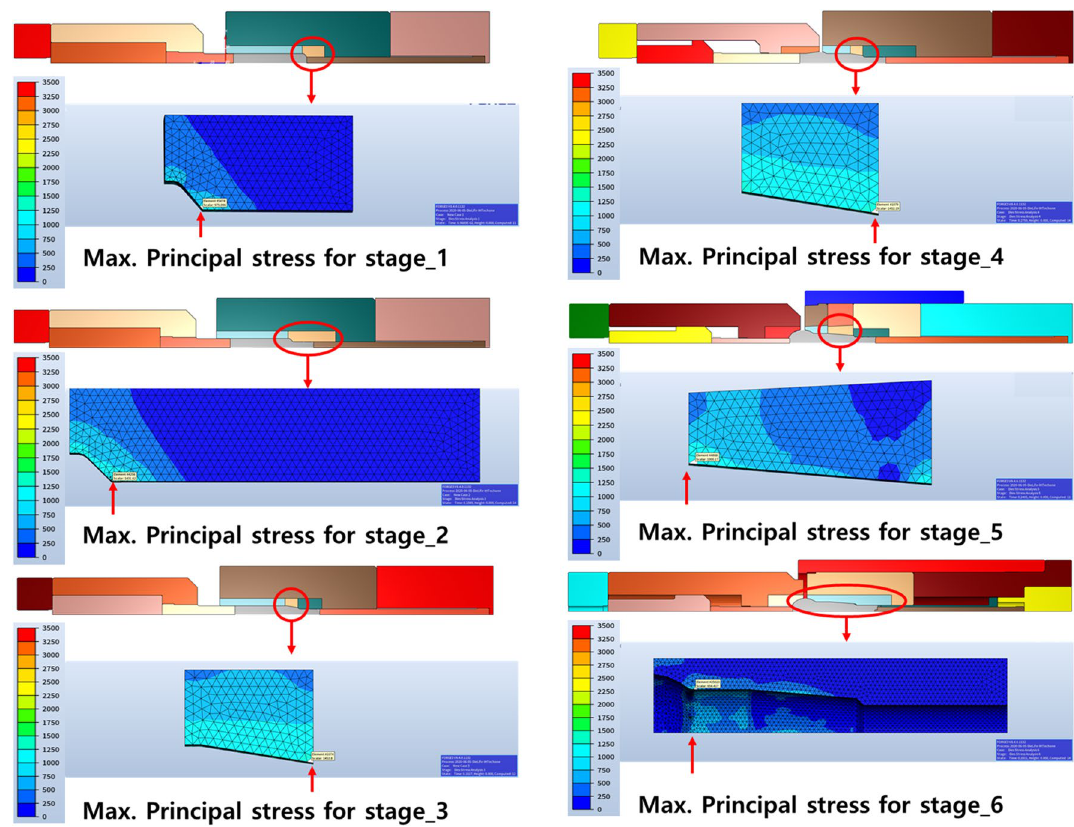
Figure 9. Max. principal stress acting on the core die of all